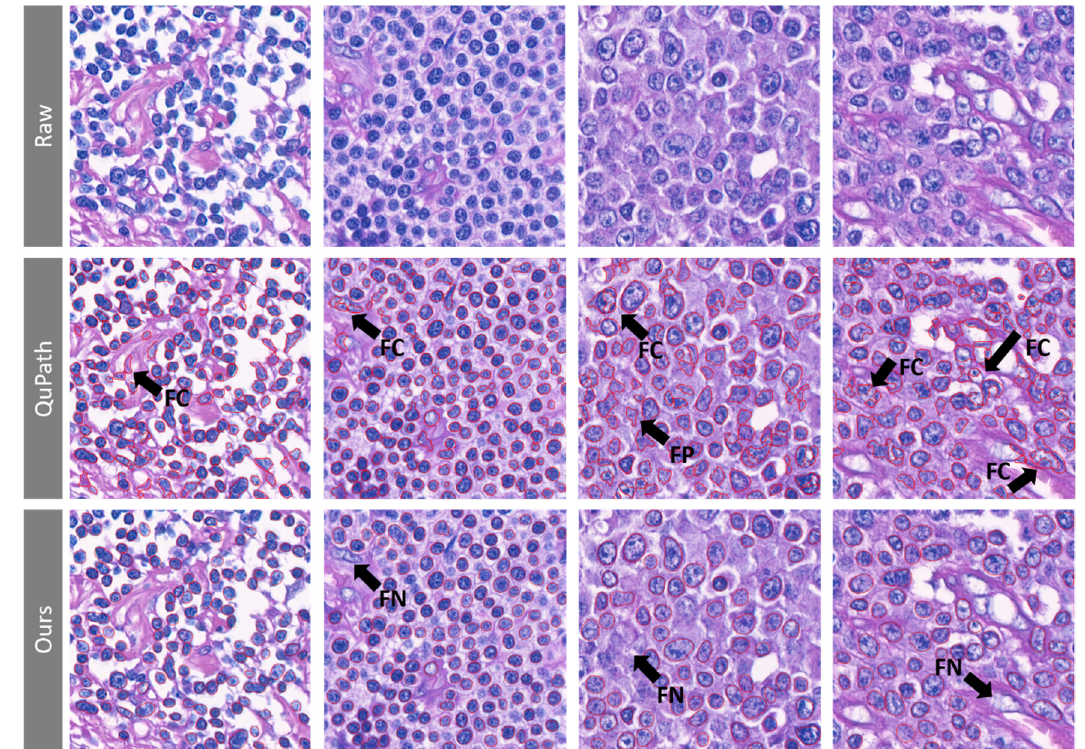
Figure 5. Comparison of contour segmentation results with the QuPath cell detection module. The first row represents the original image. For the QuPath cell detection module (the second row), default parameters were employed, except the nucleus sigma (radius of the nuclei) was set to 3 μ m due to the pixel-to- μ m ratio. Fragile contours (FC) and false positives (FP) occurred frequently in QuPath. Our lymphocyte detection model (the third row) showed fewer FC and FP but more false negatives (FN) at a score threshold of 0.2, along with an IoU threshold of 0.5, which might be due to the low confidence of the segmented